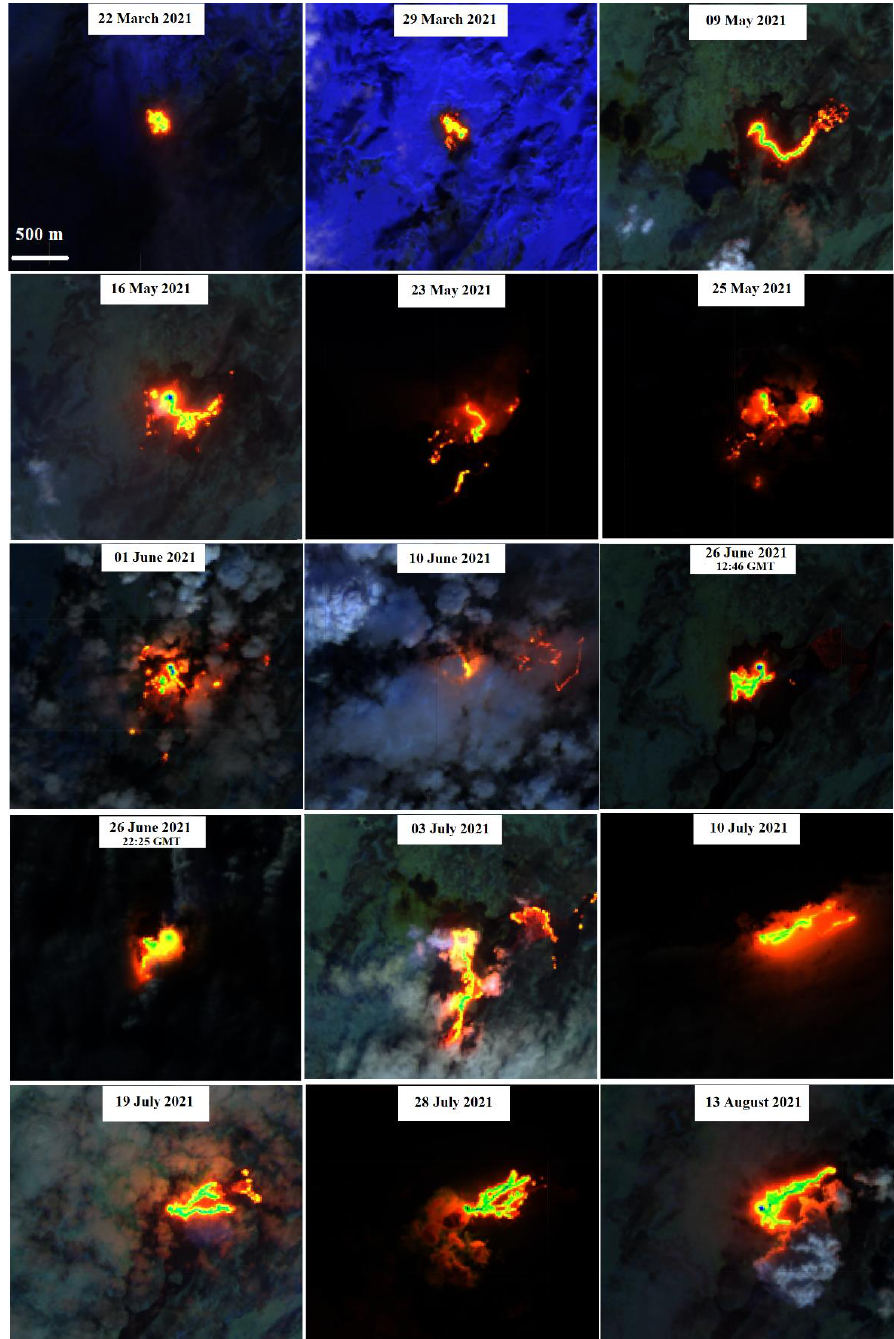
Figure 3. The images from Landsat 8-OLI (band combination 7/6/5) show the temporal evolu- tion of the 2021 Fagradalsfjall eruption. The active lava flows were detected by the satellite